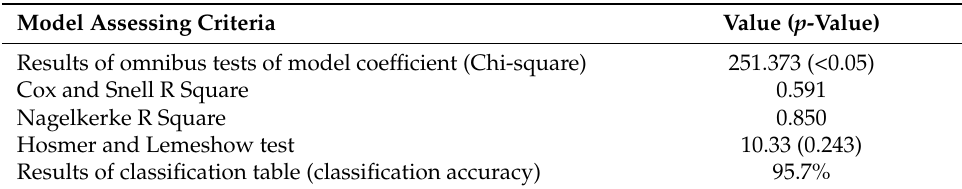
Table 4. Assessing Criteria for Multiple Logistic Regression.